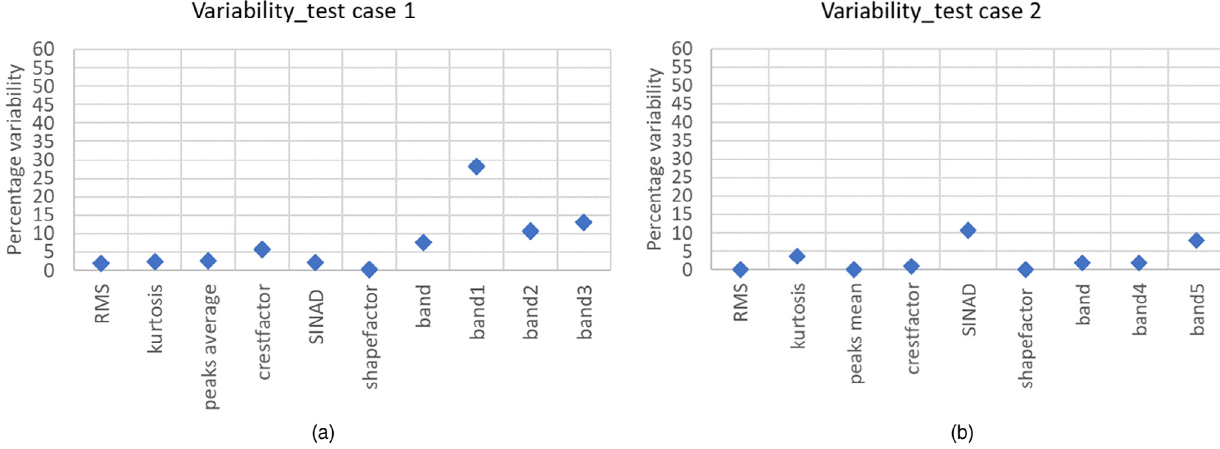
Fig. 3. Standard deviation of features for CM, in cases 1 (a) and 2 (b).